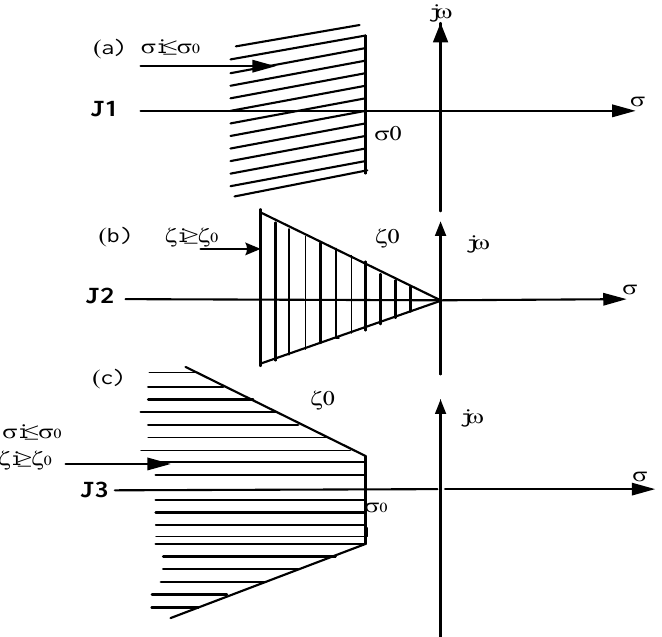
Figure 4. Region of location of eigenvalues for objective functions.